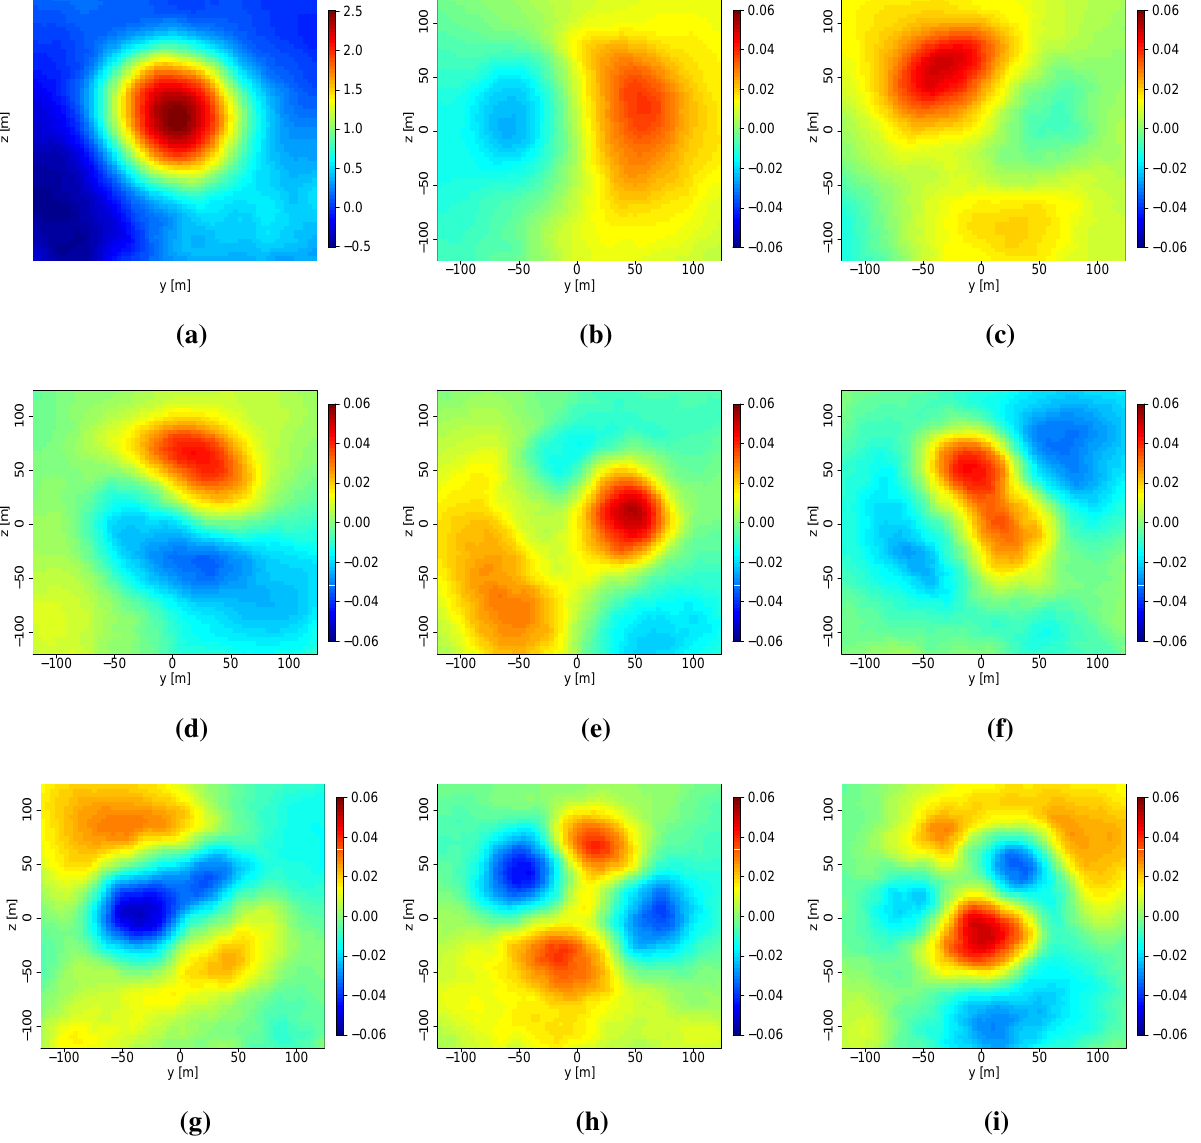
Figure A1. Mean field and POD modes. ( a ) Mean field; ( b ) Mode 1; ( c ) Mode 2; ( d ) Mode 3; ( e ) Mode 4; ( f ) Mode 5; ( g ) Mode 6; ( h ) Mode 7; ( i ) Mode